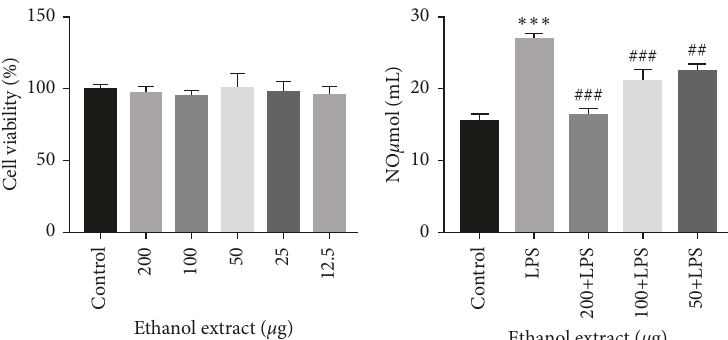
Figure 2: Effects of the ethanol extract on the viability of RAW 264.7 cells (a). Effects of the ethanol extract on NO production in LPS- induced RAW 264.7 cells (b). Data are mean ### P